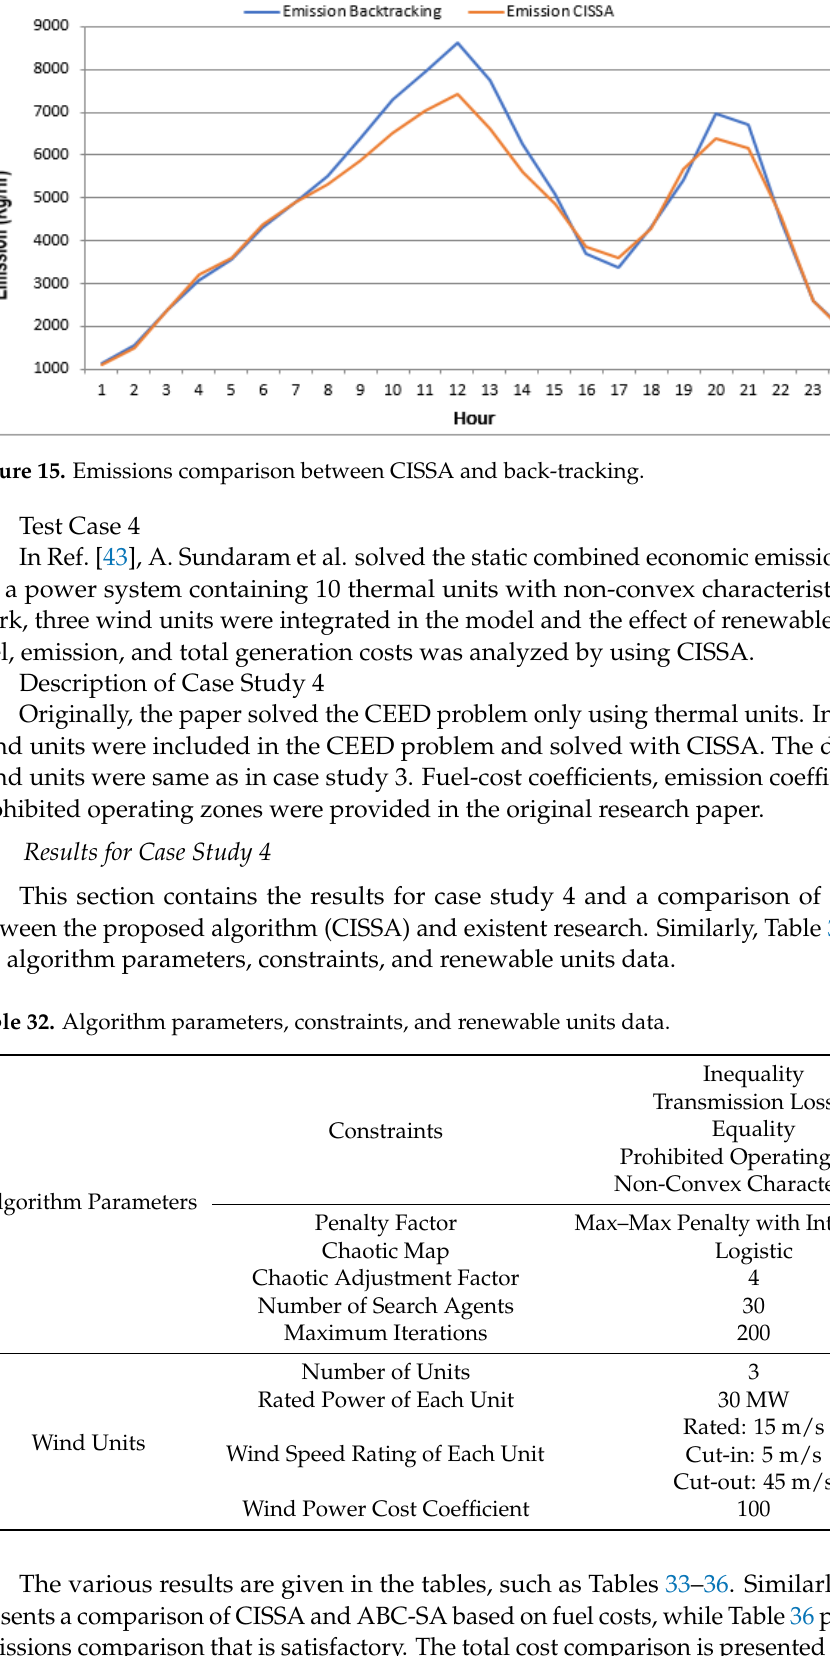
Table 32. Algorithm parameters, constraints, and renewable units data.